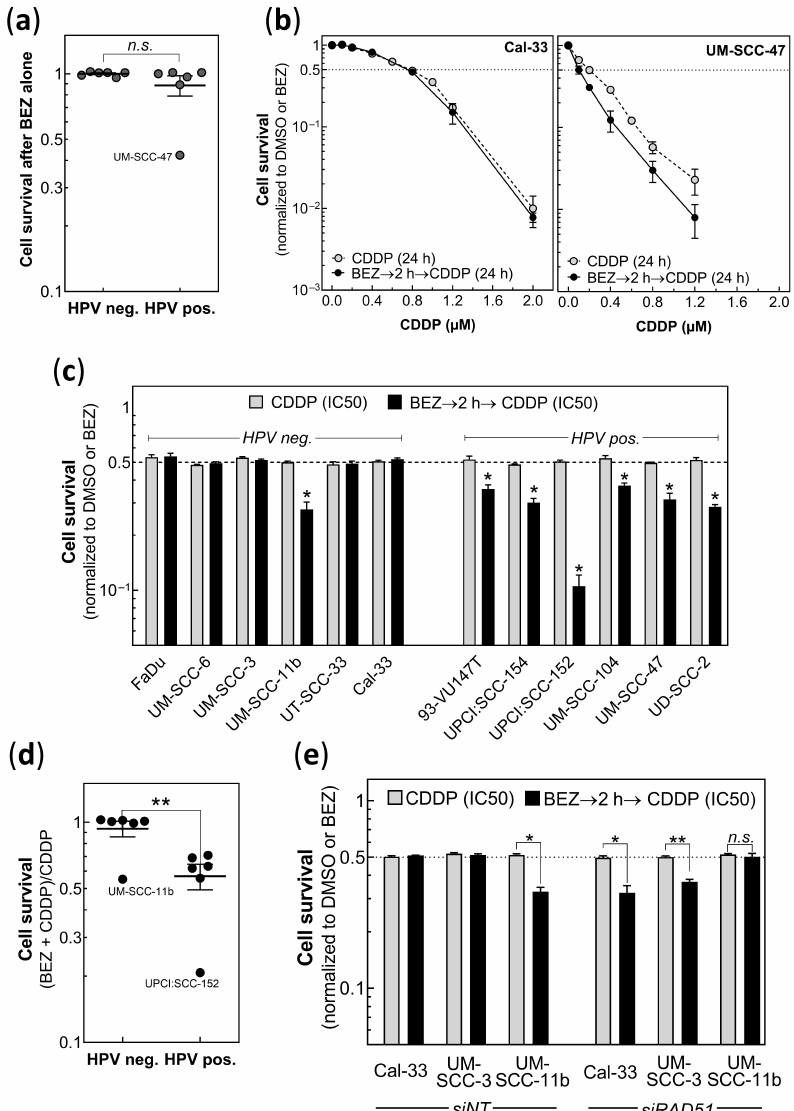
Figure 3. Effect of BEZ235 on the cisplatin sensitivity of both HPV neg. and HPV pos. HNSCC. Cells were pretreated with 50 nM BEZ235 (BEZ) for 2 h before incubation with cisplatin (CDDP) for 24 h. ( a ) Effect of BEZ235 alone. ( b ) Effect of pretreatment with BEZ on the cisplatin sensitivity of Cal-33 and UM-SCC-47 cells, respectively. ( c ) Effect of cisplatin alone or after pretreatment with BEZ235, as determined for all six HPV neg. and pos. cell lines. For cisplatin, the respective IC50 doses were used as taken from Figure 1. ( d ) Relative reduction in cell survival as achieved for HPV neg. or pos. cell lines by the combined treatment of BEZ235 and CDDP after normalization to the effect of cisplatin alone. ( e ) Effect of RAD51 KD (siRAD51) compared to non-target control (siNT) on the combination of BEZ235 and cisplatin for HPV neg. HNSCC cell lines using the IC50 concentrations as shown in Figure 2d. ( b , c , e ) Cell survival is always normalized to cells non-treated by CDDP. Data presented as mean values ± SEM, n ≥ 3, * p = 0.05; ** p = 0.001, n.s. : non significant.